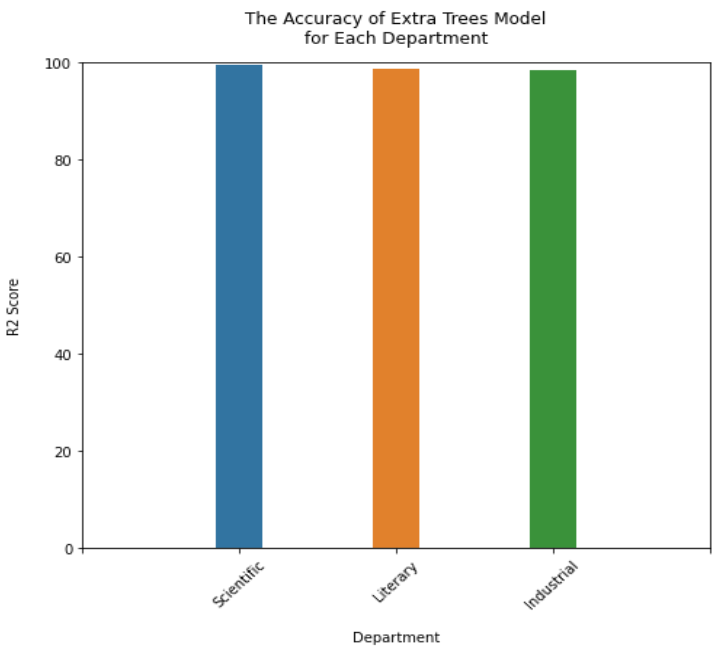
Figure 3. Accuracy of Extra Tree Model.